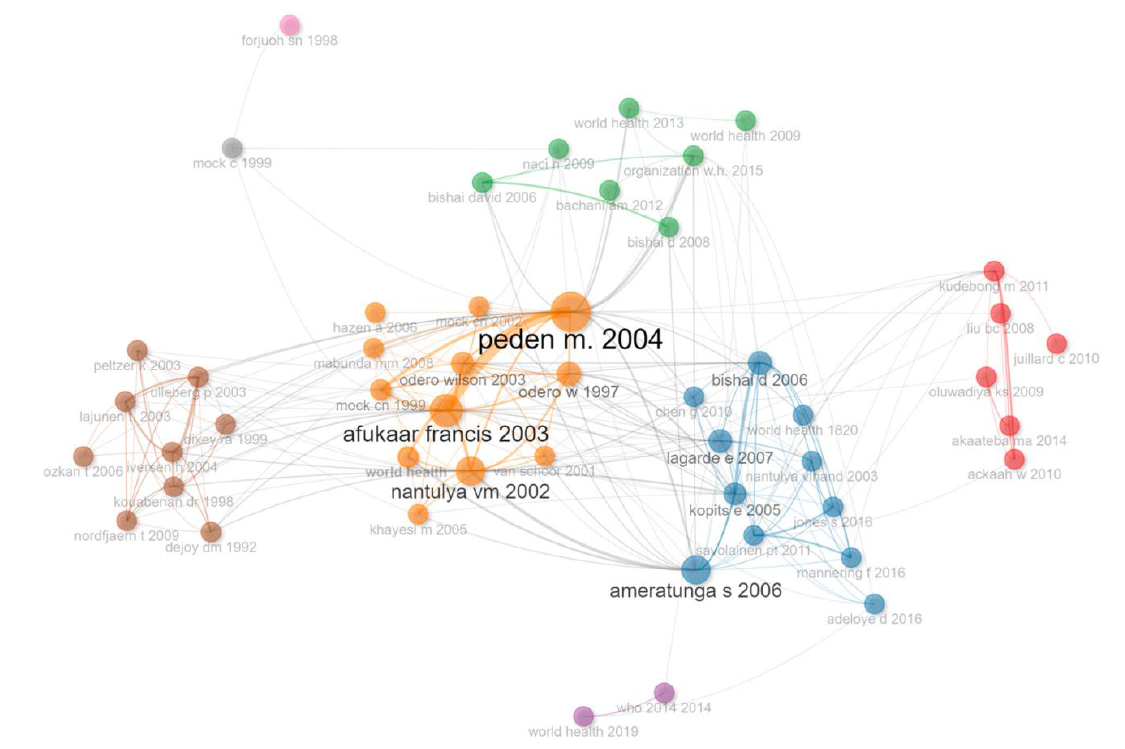
Figure 6. Co-citation analysis. So urce: Author’s own, based on Web of Science search .